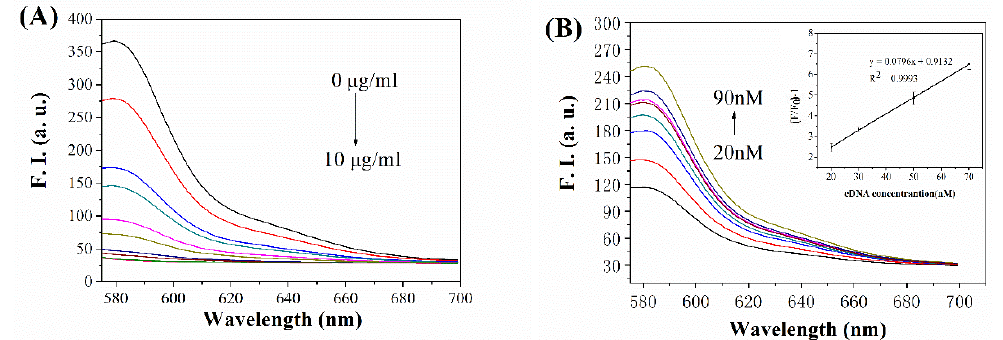
Figure 2. ( A ) The fluorescence intensity of TAMRA labled T-DNA (20 nM) in the presence of various concentrations of GO (0, 2, 3, 4, 5, 6, 7, 8, 9, 10 µ g/mL); ( B ) the fluorescence intensity of T-DNA-GO in the presence of different concentrations of cDNA (20, 30, 40, 50, 60, 70, 80, and 90 nM); (insert) the values of [(F/F 0 )-1] for assay with the concentration of cDNA.